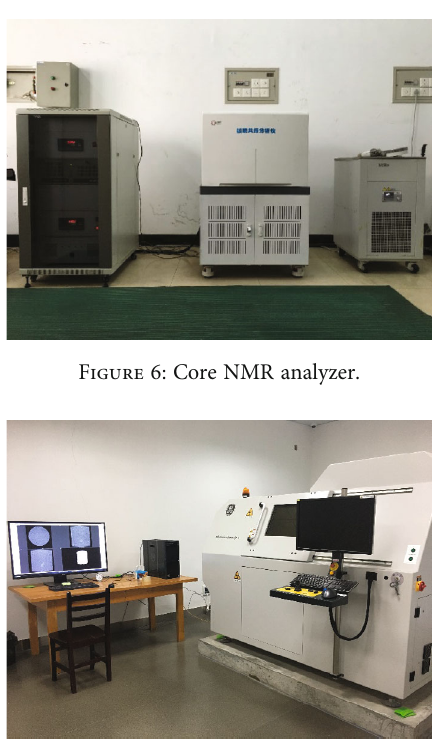
Figure 7: V|tome|xs micro-CT